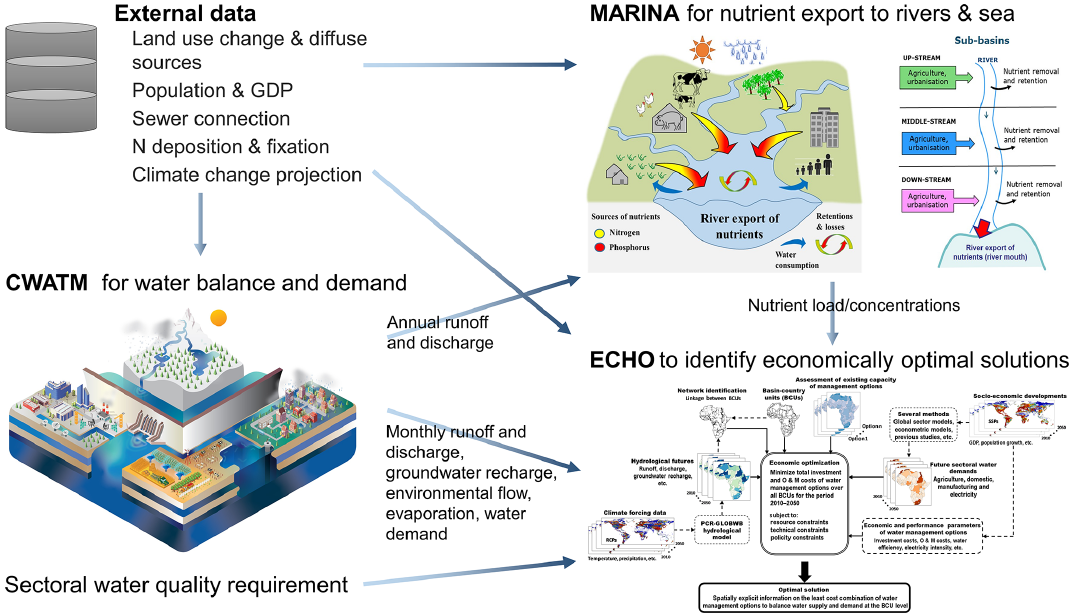
Figure 15. Schematic view of the interaction among CWatM, ECHO, and MARINA.